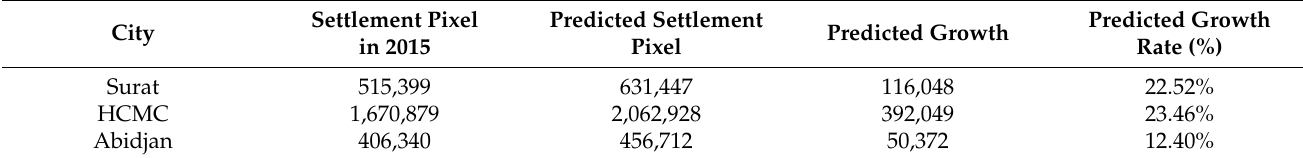
Table 5. Predicted settlement growth of the case cities from 2016 to 2025 (unit: number of pixels).